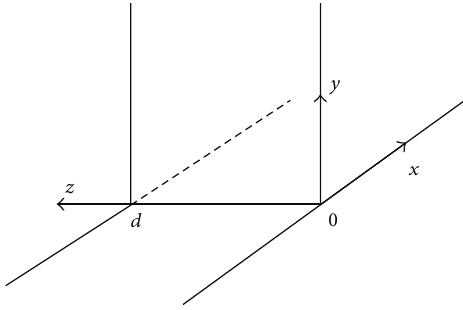
Figure 1: The schematic diagram of system considered